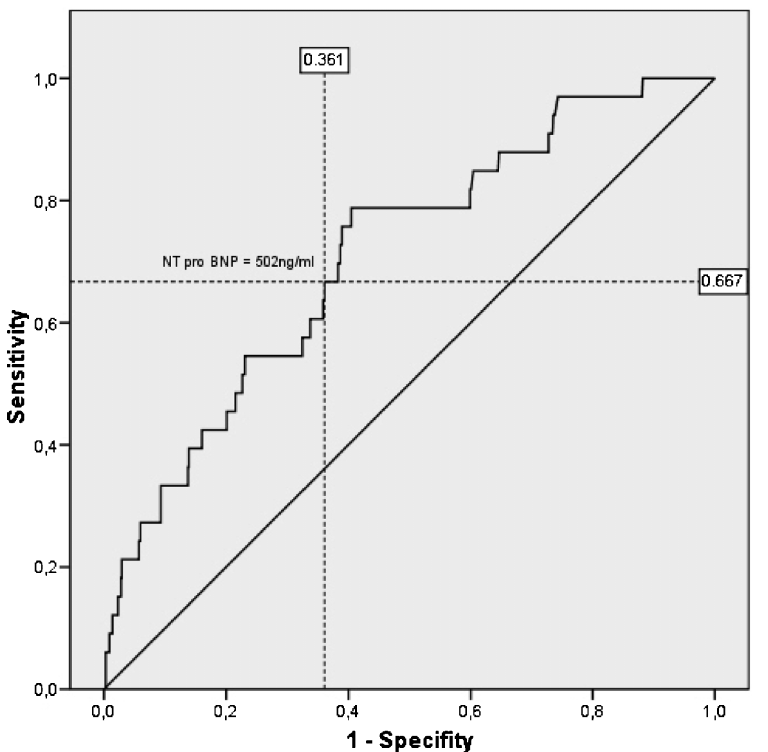
Figure 1 - Receiver operating characteristic curve of N-terminal pro-brain type natriuretic peptide (NT-proBNP) level predicting overall death.